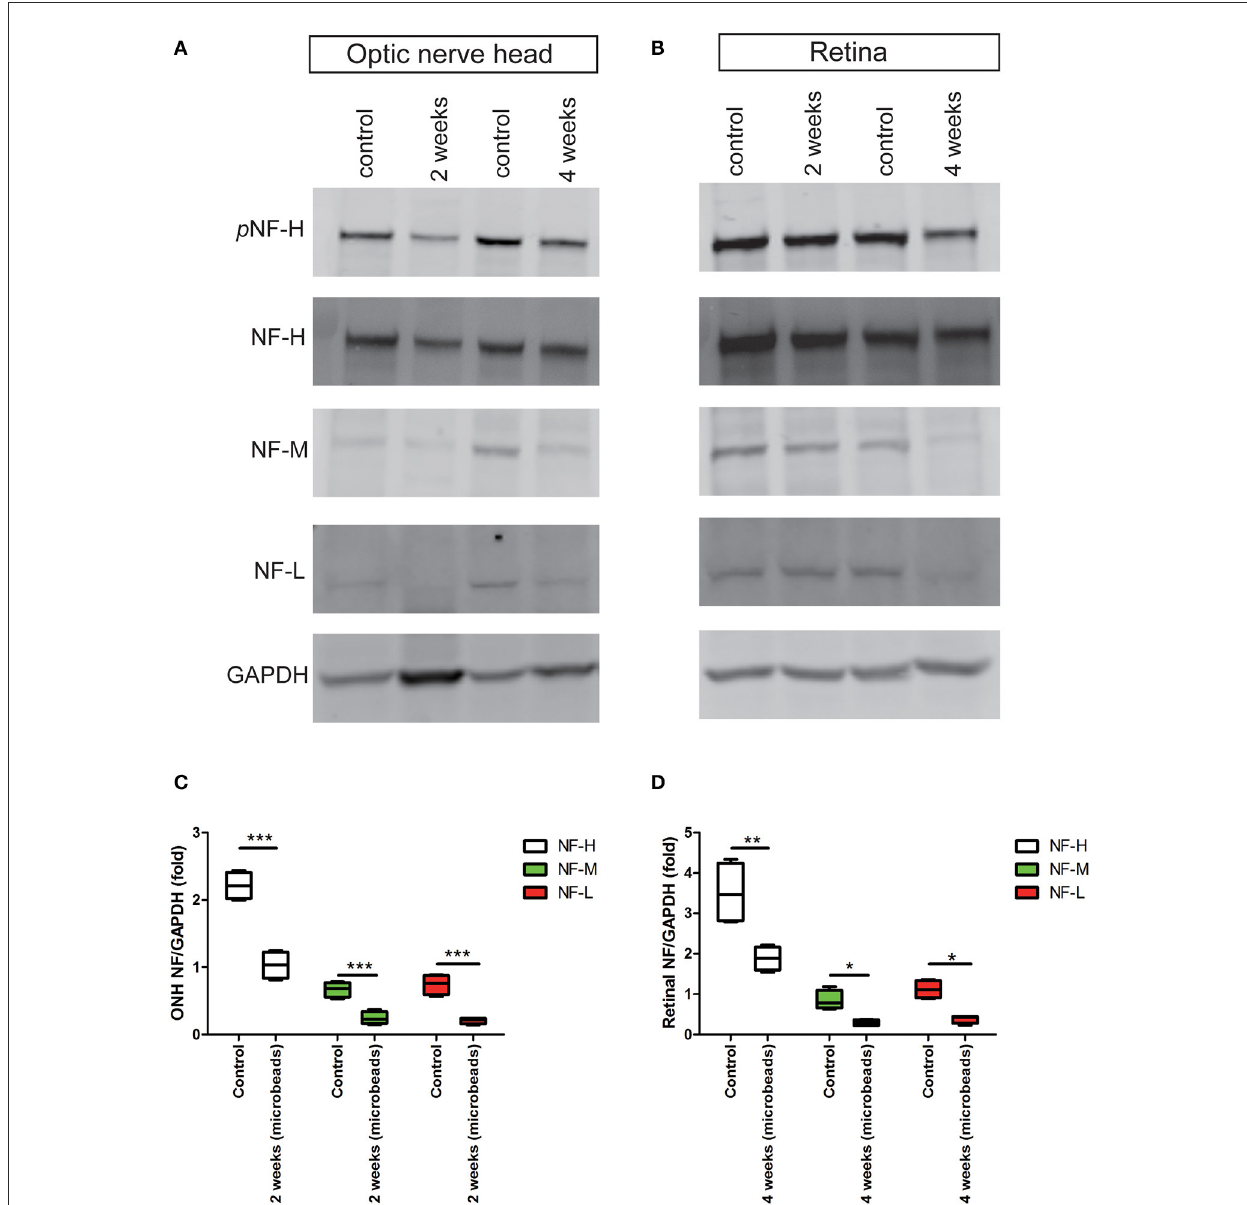
FIGURE6 Early reduction in pNF-H and NF-H expression in the ONH after chronic ocular hypertension. (A) Western blot showing control and treated ONH 2 and 4 weeks after COH occurred. pNF-H and NF-H was recognized at 200 kDa, NF-M was visible at 160 kDa, and NF-L was visible at 70 kDa, with GAPDH as the internal control. The density of pNF-H and neurofilament subunit bands started to reduce at 2 weeks. (B) Representative blots from control and treated retinas 2 and 4 weeks after COH occurred. The density of pNF-H and NF-H began to reduce 4 weeks after COH occurred. (C, D) Densitometry measurements of three neurofilament subunits in the ONH and the retina (normalized for GAPDH and expressed relative to the control) are provided in the box-and-whisker plots, N = 4 for each group, * P < 0.05, ** P < 0.01, *** P <